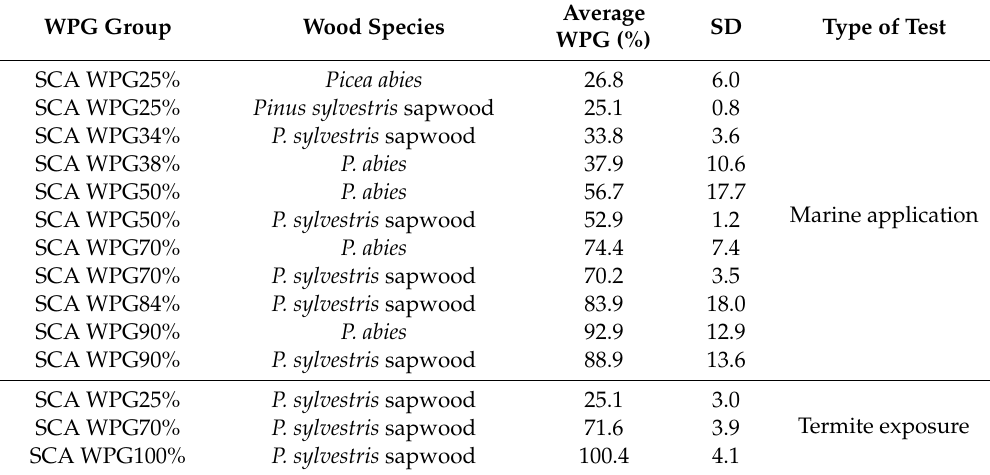
Table 1. Overview of weight percentage gain (WPG) of sorbitol and citric acid (SCA)-treated Scots pine and spruce wood samples used in field tests in the marine environment and in termite exposure. SD, standard